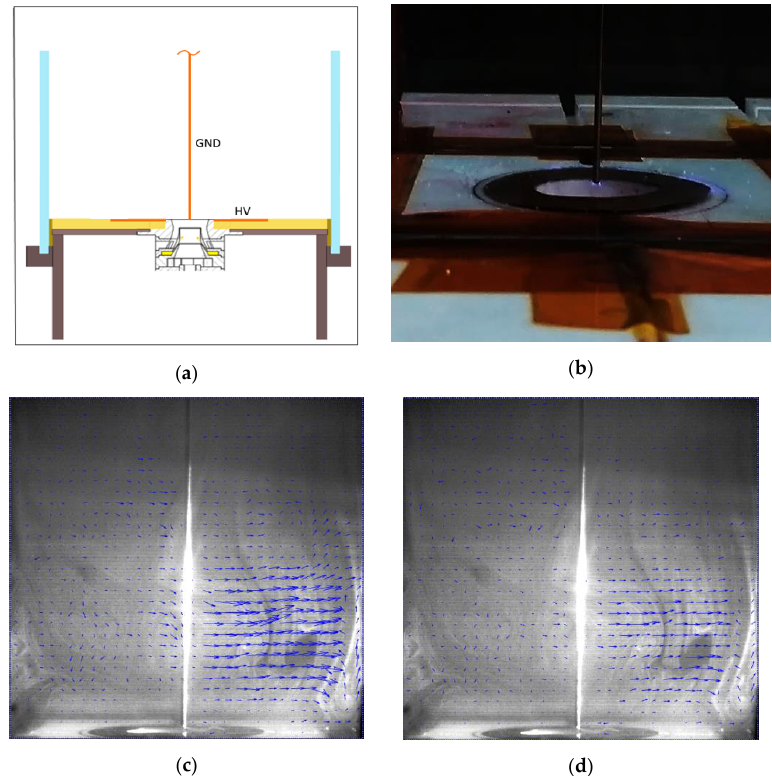
Figure 1. ( a ) A sketch of the burner indicating the electrodes, GHD: grounded electrode and HV: annular high-voltage electrode, ( b ) location of plasma, ( c ) instantaneous streamlines for the test case 2 (standoff distance 0 mm), and ( d ) instantaneous streamlines for the test case 3 (standoff distance 20 mm).